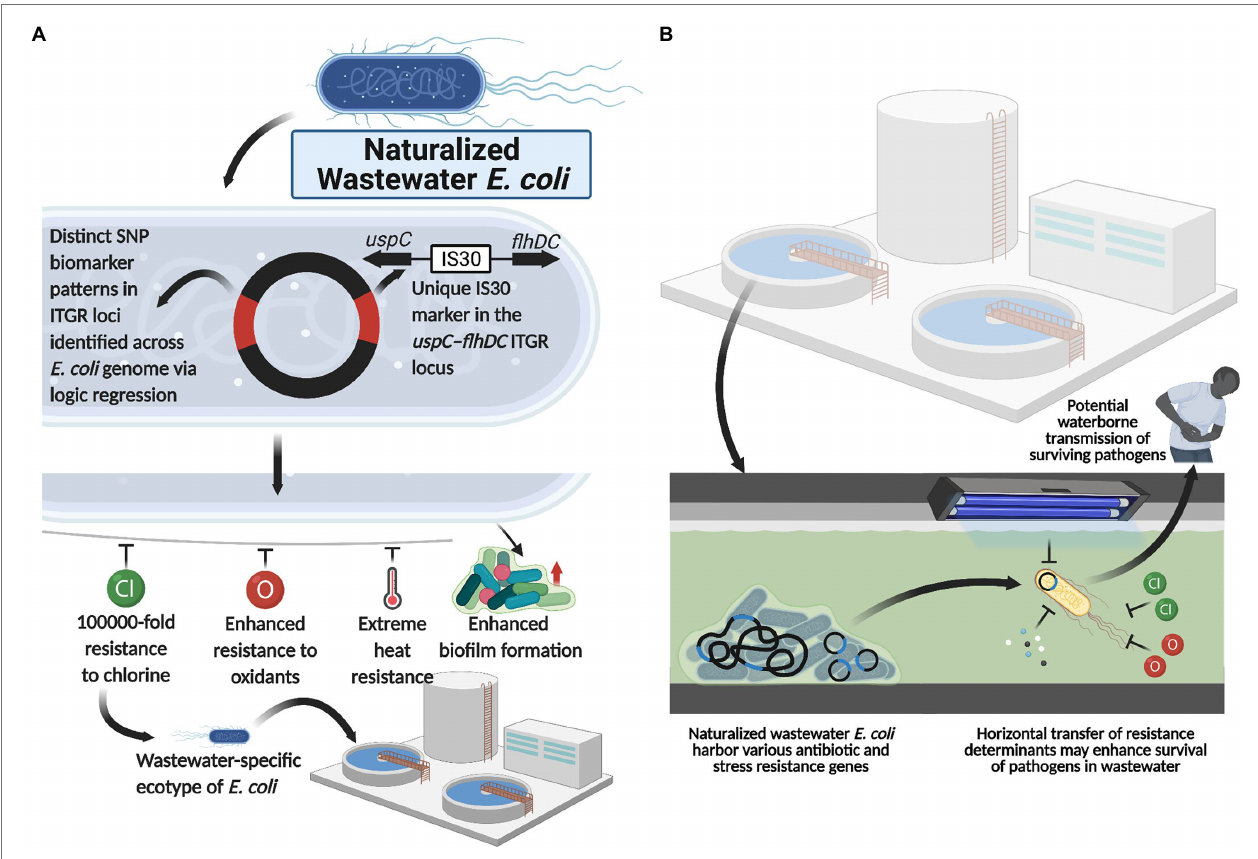
FIGURE 2 | Naturalized wastewater E. coli as a reservoir for antibiotic and water treatment resistance. (A) Naturalized wastewater E. coli strains harboring unique SNP ITGR biomarkers and the uspC–IS30–flhDC genetic marker are characterized by various phenotypic adaptations, including extreme heat, chlorine and oxidant resistance as well as enhanced biofilm formation capacity, which appear to underlie their recent naturalization into wastewater matrices. In line with this, these naturalized strains harbor an abundance of antibiotic and stress resistance genes that may be mobilized and acquired by other microbes in the wastewater matrix, including pathogenic strains. Importantly, this suggests that (B) naturalized wastewater microbes may serve as reservoirs for both antibiotic resistance and water treatment resistance, enhancing the survival and transmission of pathogens present in wastewater. Created with